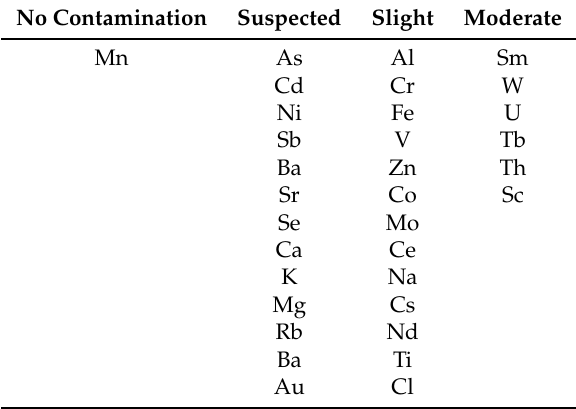
Table 3. Classification of elements according to the degree of contamination.